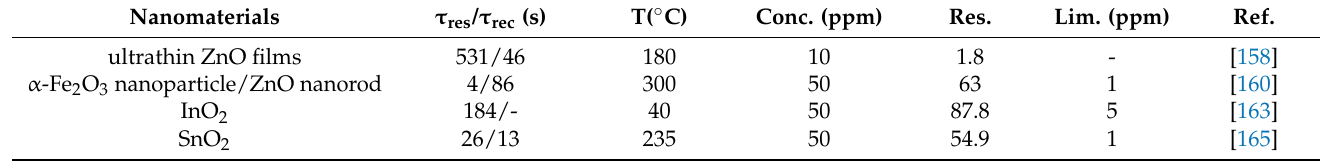
Figure 26. Schematic diagram of the electrospinning device [164]. A summary of the performance of the sensors manufactured with the various devices in this section is given in Table 4 at the end of this section. Table 4. The gas-sensing properties of various materials fabricated by different devices.